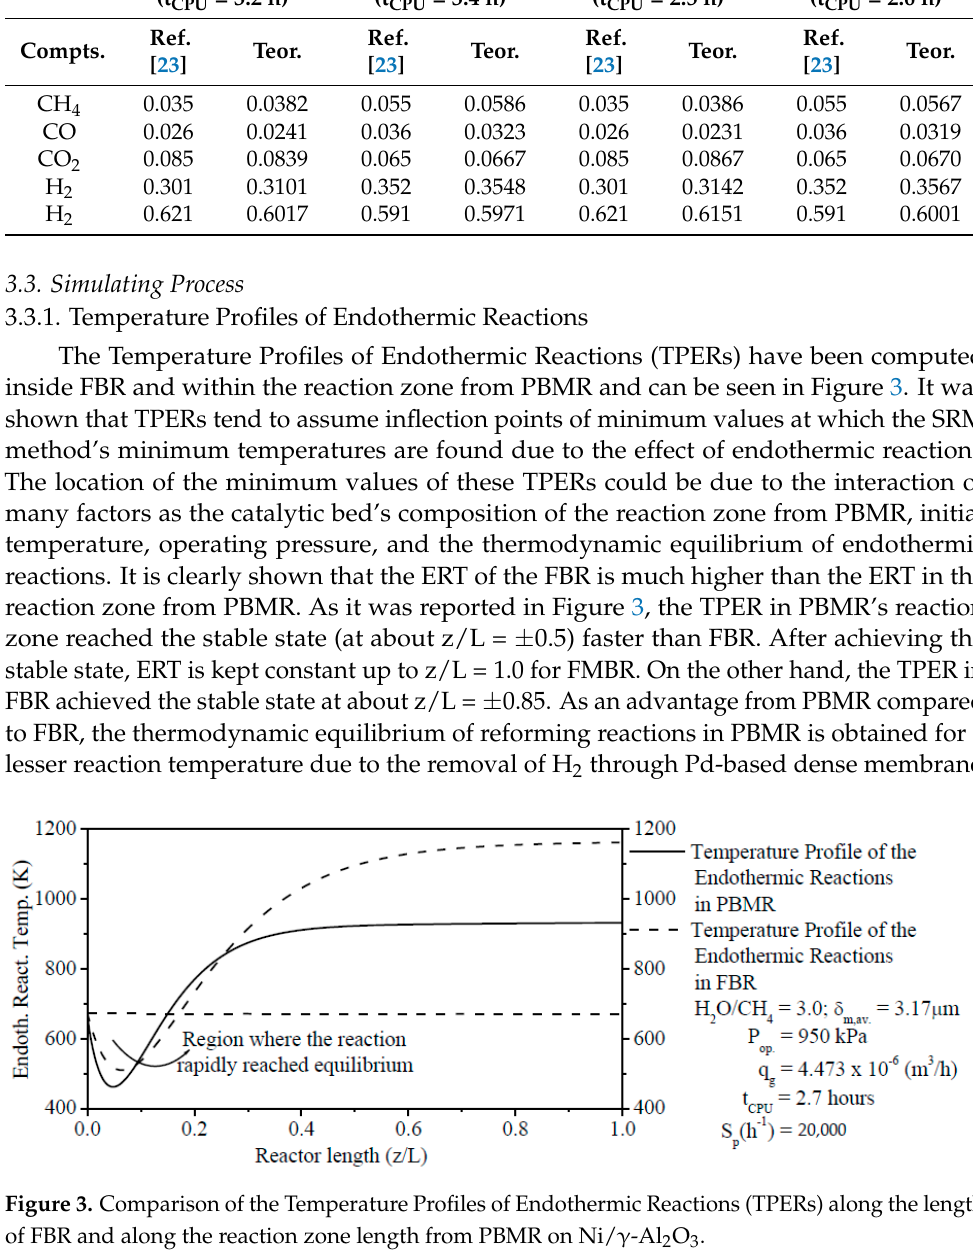
Figure 4. Effect of the H 2 O/CH 4 ratio on the ERT along the reaction zone length from PBMR on Ni/ γ - Al 2 O 3 .